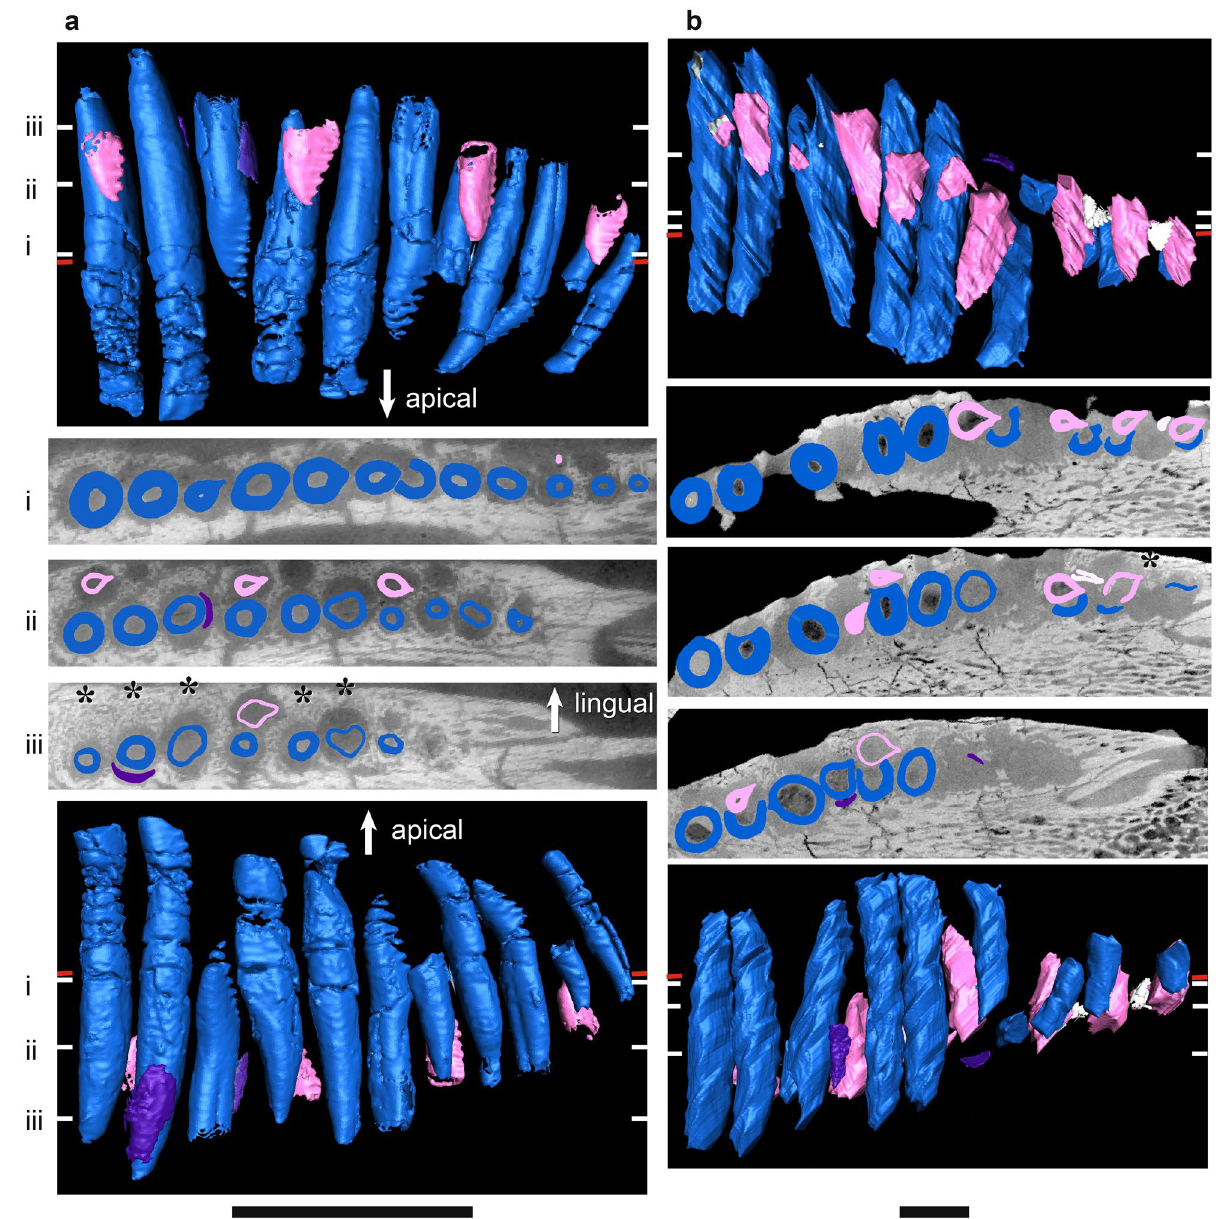
Figure 6. µCT scans of basal endothiodont mandibular ‘postcanine’ teeth in horizontal section (middle three rows), lingual view (top row), and labial view (bottom row). ( a ) Niassodon mfumukasi ML 1620 (mirrored), ( b ) Abajudon kaayai NHCC LB314 (mirrored). Horizontal sections were taken at numbered positions indicated on the labial and lingual views. The level of the gumline is indicated by a red tick mark on labial and lingual views. First-generation replacement teeth are highlighted in light pink, second-generation replacement teeth in white, functional teeth in medium blue, and tooth remnants in dark purple. Anterior is to the left. Scale bars 5 mm. Asterisks indicate visible alveolar bone